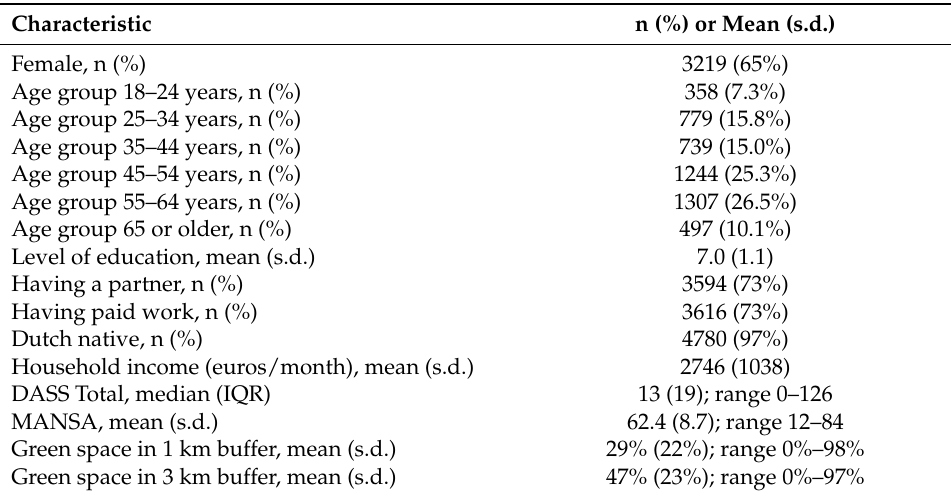
Table 1. Descriptive characteristics of the participants ( n =